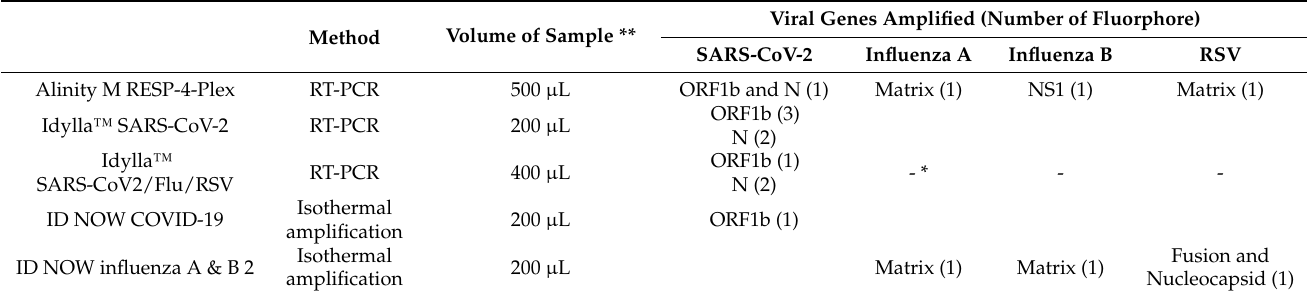
Table 1. Characteristics of the reference RT-PCR and evaluated